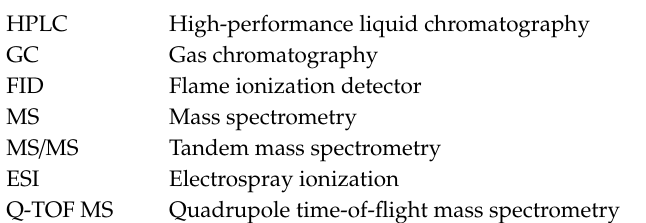
Figure S1: TLC of reaction models between protected reactive amino acids (N α -Boc-arginine, N α -Boc-lysine, and N α -Boc-methionine) and oxysterol (cholesterol 5 α ,6 α -epoxide); Figure S2: Levels of cholesterol 5 α ,6 α -epoxide in blank samples over the incubation time at 180 ◦